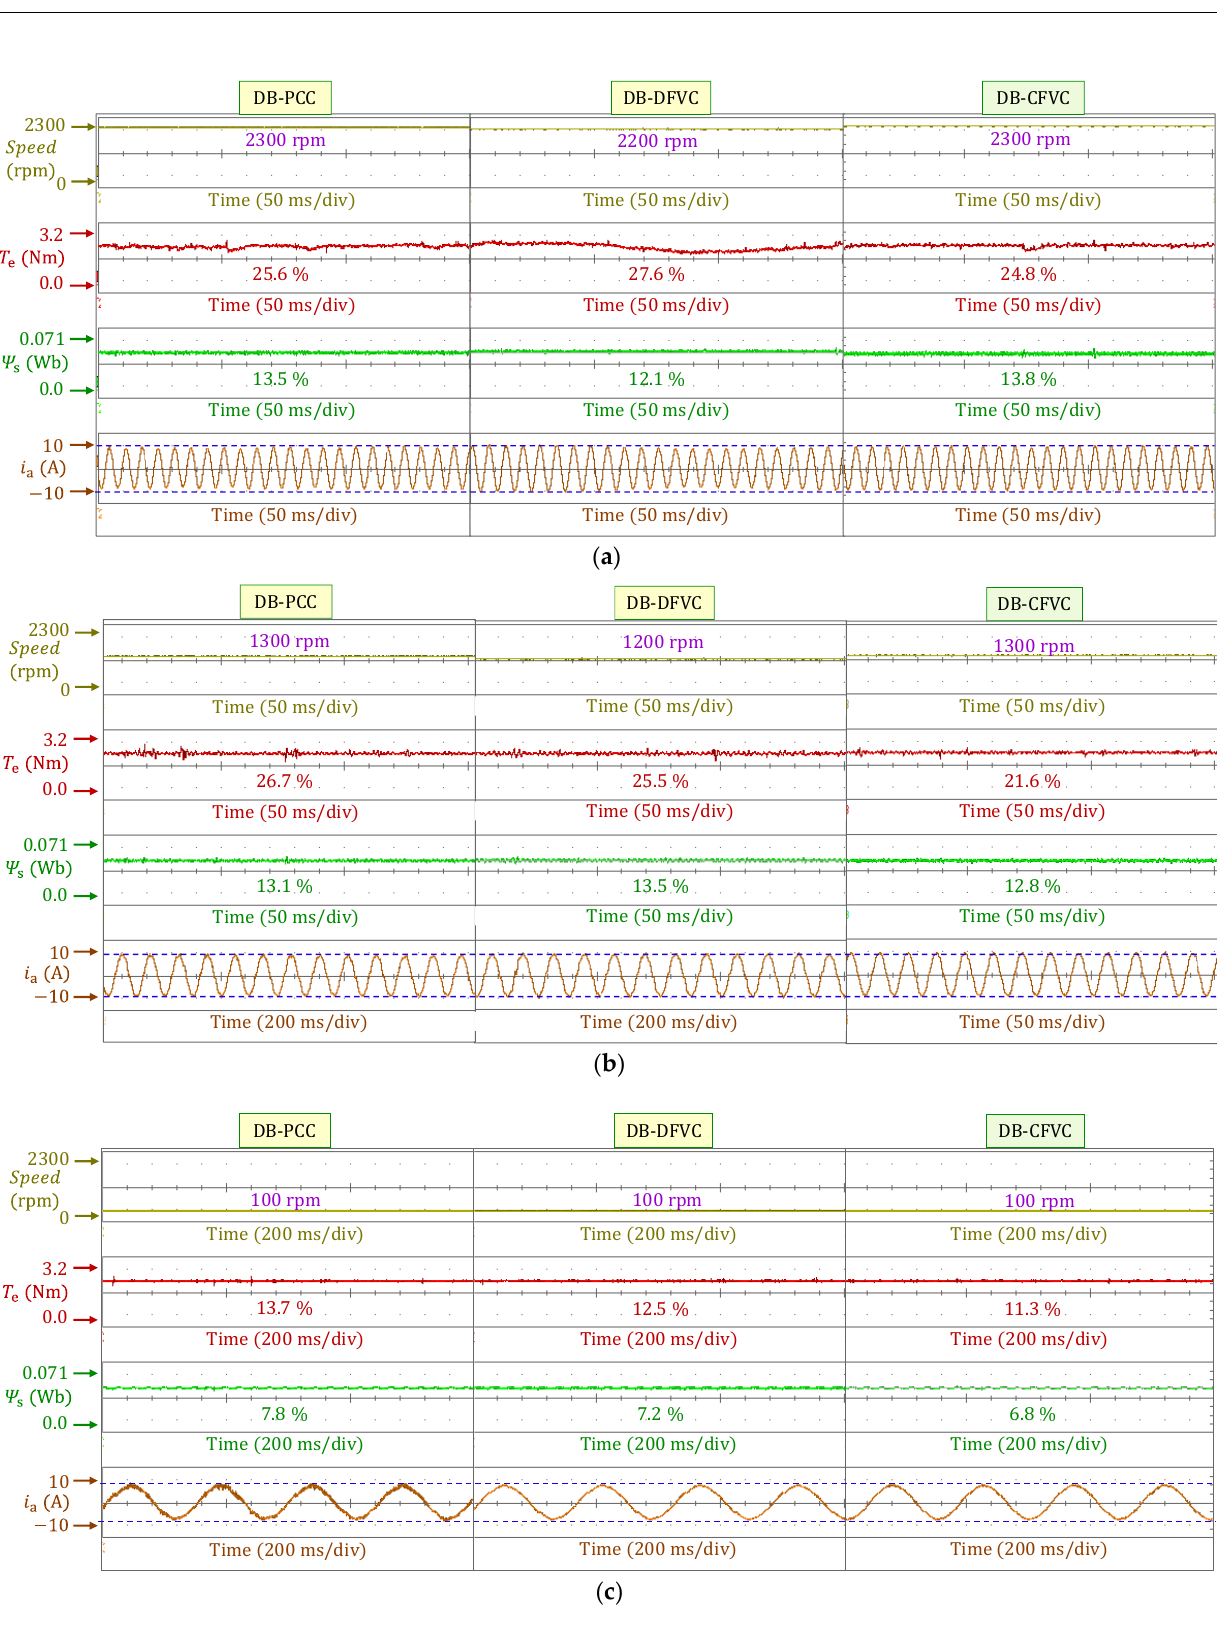
Figure 7. Comparison of speed, torque, flux linkage, and current between conventional DB-PCC, DB-CFVC, and proposed DB-CFVC at steady state under load torque of 2.5 Nm at various speed references of ( a ) 2300 rpm, ( b ) 1300 rpm, and ( c ) 100 rpm.